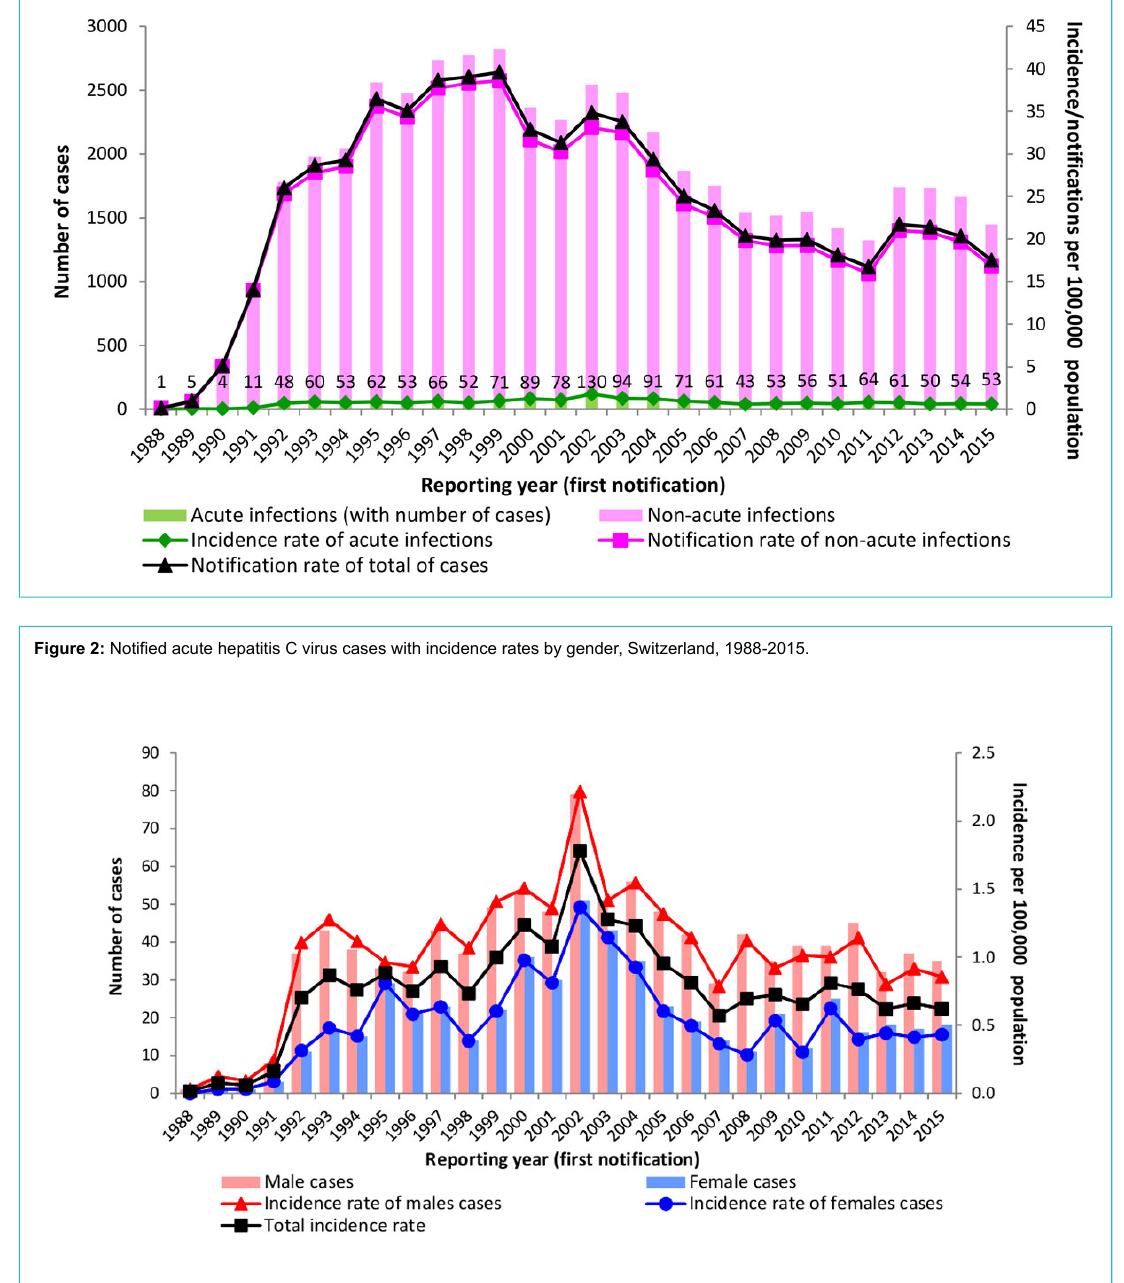
Figure 1: Notified acute and non-acute hepatitis C virus cases with incidence and notification rates, Switzerland, 1988-2015.